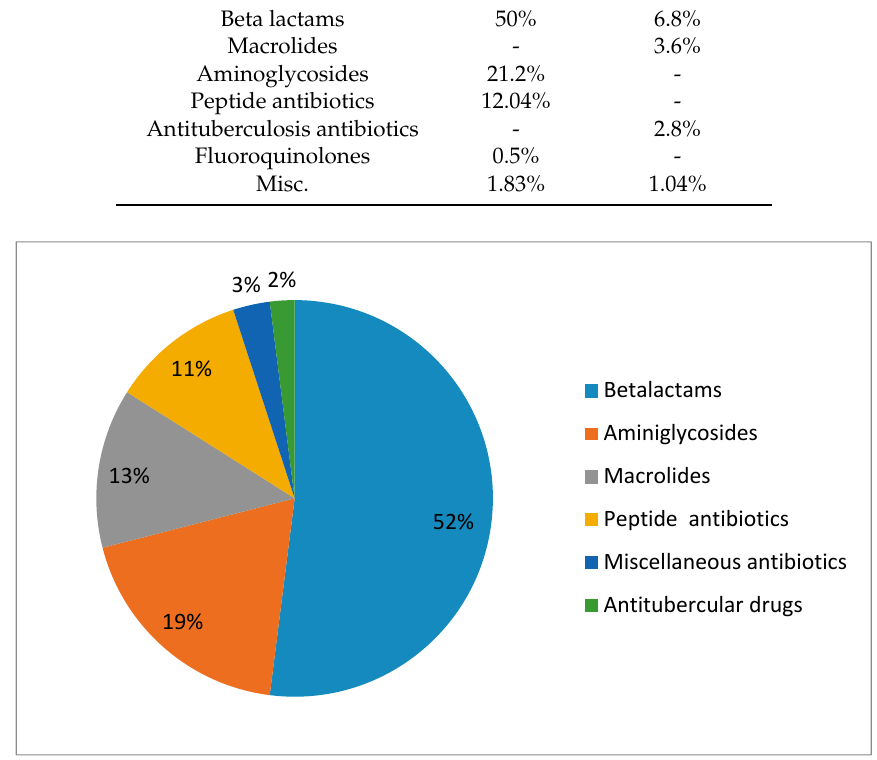
Figure 3. Percentages of prescribed antibiotics.